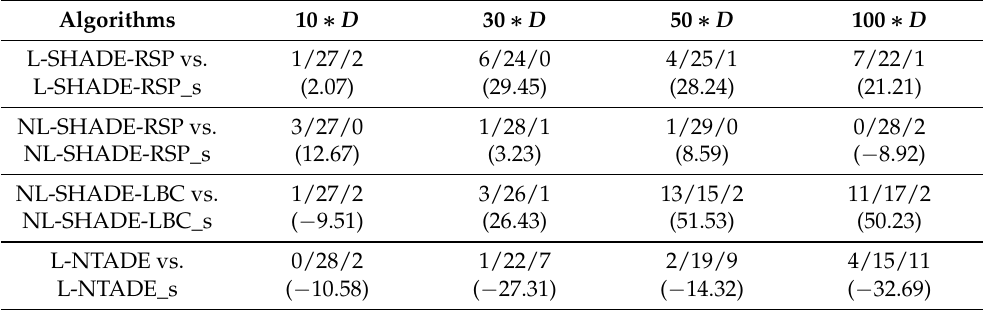
Table 1. Algorithms with and without crossover rate sorting, CEC 2017, Mann–Whitney tests and total standard score.